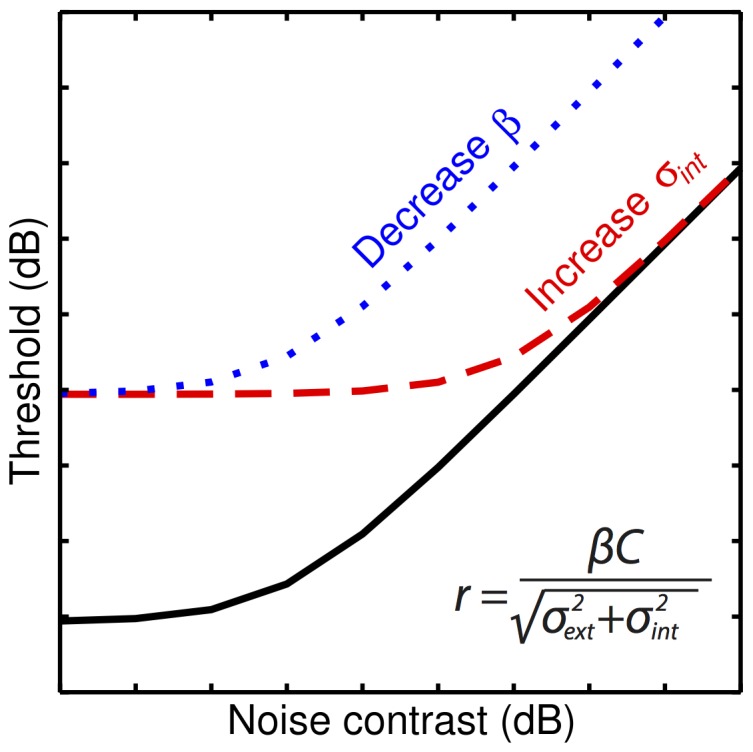
Canonical noise masking functions showing the effect of changing model parameters.The dashed and dotted curves show the effect of changing the level of internal noise (σint in equation 2– see Materials and Methods section) or the observer’s efficiency (β in equation 2), relative to the solid curve.